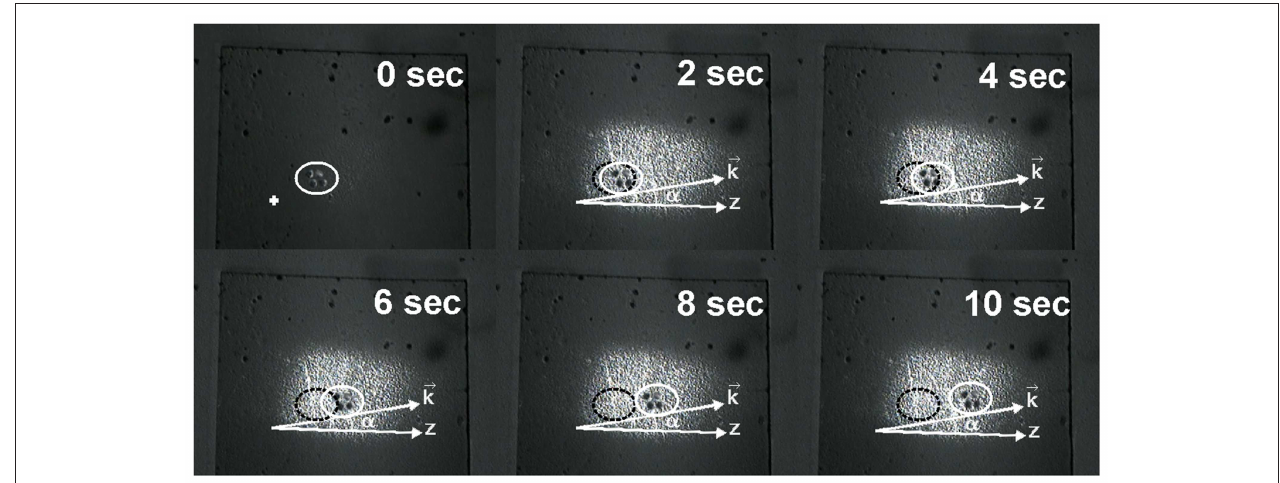
FIGURE 3 | Photos demonstrating the change of gold nanoparticles about 60nm size locations by the action of the evanescent wave, produced in the near-surface layer of the tissue: white ellipse notes the position of managed nanoparticles at different moments of time; black ellipse notes the initial position of these particles. α is the angle between directions z and E k (vector determining the direction of the resulting optical force E F